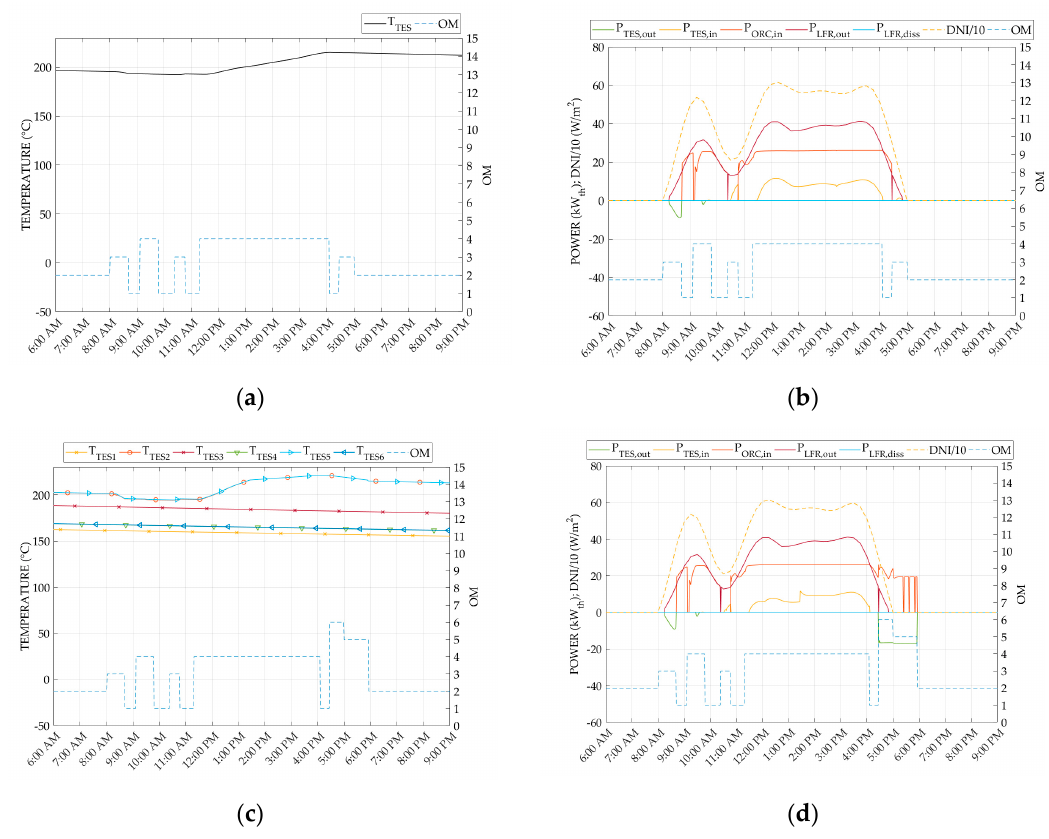
Figure 8. Daily temperatures ( a ) and power trends ( b ) of the LHTES compared with the daily temperature ( c ) and power trends ( d ) of the sub-LHTES for a typical mid-season day (11 October). The graphs represent also the operating mode (OM) of the plant, as specified in Table 1. Table 2. Annual energy balance and performance of the plant with and without the smart fuzzy logic